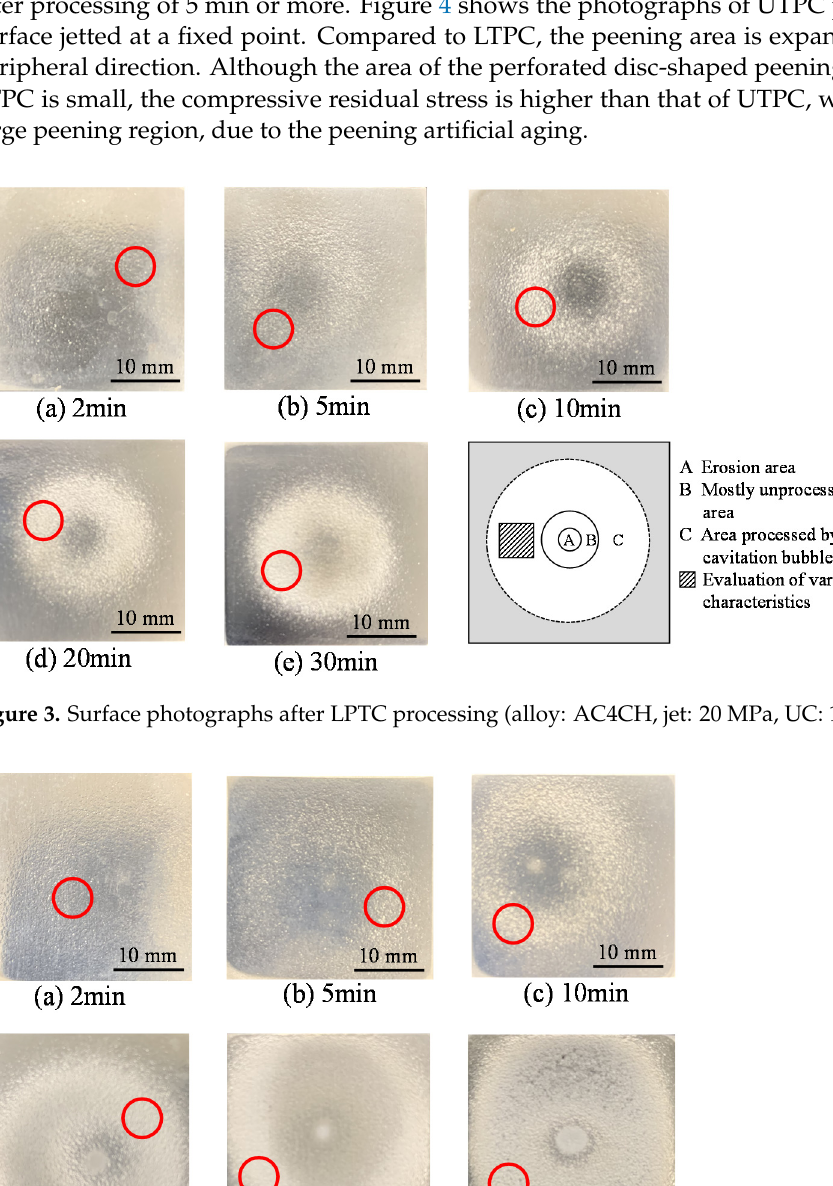
Figure 2. Schematic diagram of peening artificial aging by LTPC and peening natural aging by UTPC.